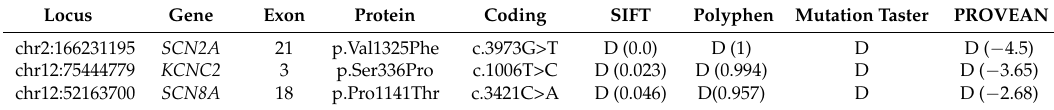
Table 1. Overall results of whole-exome